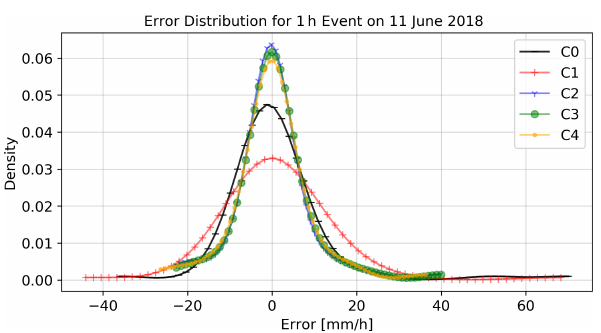
Figure 10. Distribution of the cross validation errors for the time period from 15:00 to 16:00LT on 11 June 2018 for the five inter- polation methods. C0 – using primary stations only and OK; C1 – primary and all secondary, without filter and OK; C2 – primary and secondary, using IBF and OK; C3 – primary and secondary, us- ing IBF, EBF and OK; C4 – primary and secondary, using IBF, EBF and